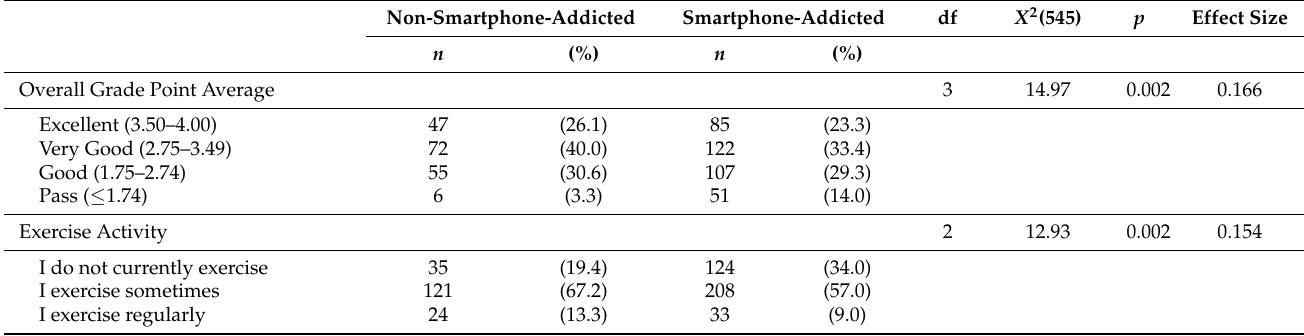
Table 7. Comparison of academic, physical health and mental well-being information between smartphone-addicted and non-smartphone-addicted groups, N =